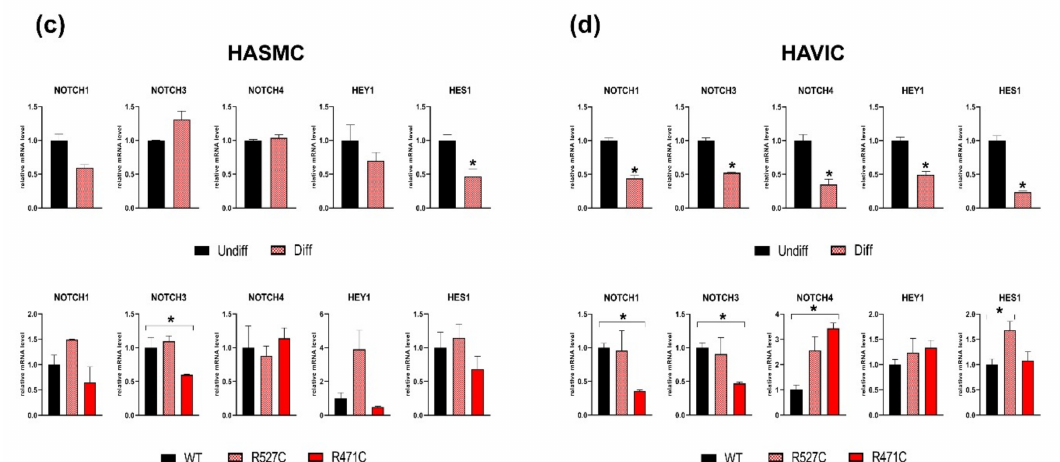
Figure 4. The effect of LMNA R527C and LMNA R471C mutations on the Notch pathway activity in human mesenchymal cells. Cells were differentiated in osteogenic direction for 3 days. Upper panel for each types of cells: HUVEC ( a ), HCMC ( b ), HASMC ( c ) and HAVIC ( d ) represent the analysis of Notch target gene expression by qPCR in undifferentiated cells (Undiff) and after 3 days of osteogenic differentiation (Diff). Lower panel for each types of cell ( a , b , c , d ) represents the analysis of Notch target gene expression by qPCR in cells transduced with lentivirus bearing either LMNA WT (WT) or LMNA R527C/LMNAR471C (R527C/R471C). The results are represented as mean ± SD; * p <